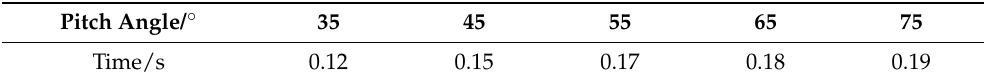
Figure 13. The pitch angle is adjusted by the forelimbs: ( a ): Minimum pitch angles of the prototype during takeoff; ( b ): Maximum pitch angles of the prototype during takeoff; ( c ) The large forward swing of the forelimb. Table 5. Swing time from different pitch angles to the limit position.